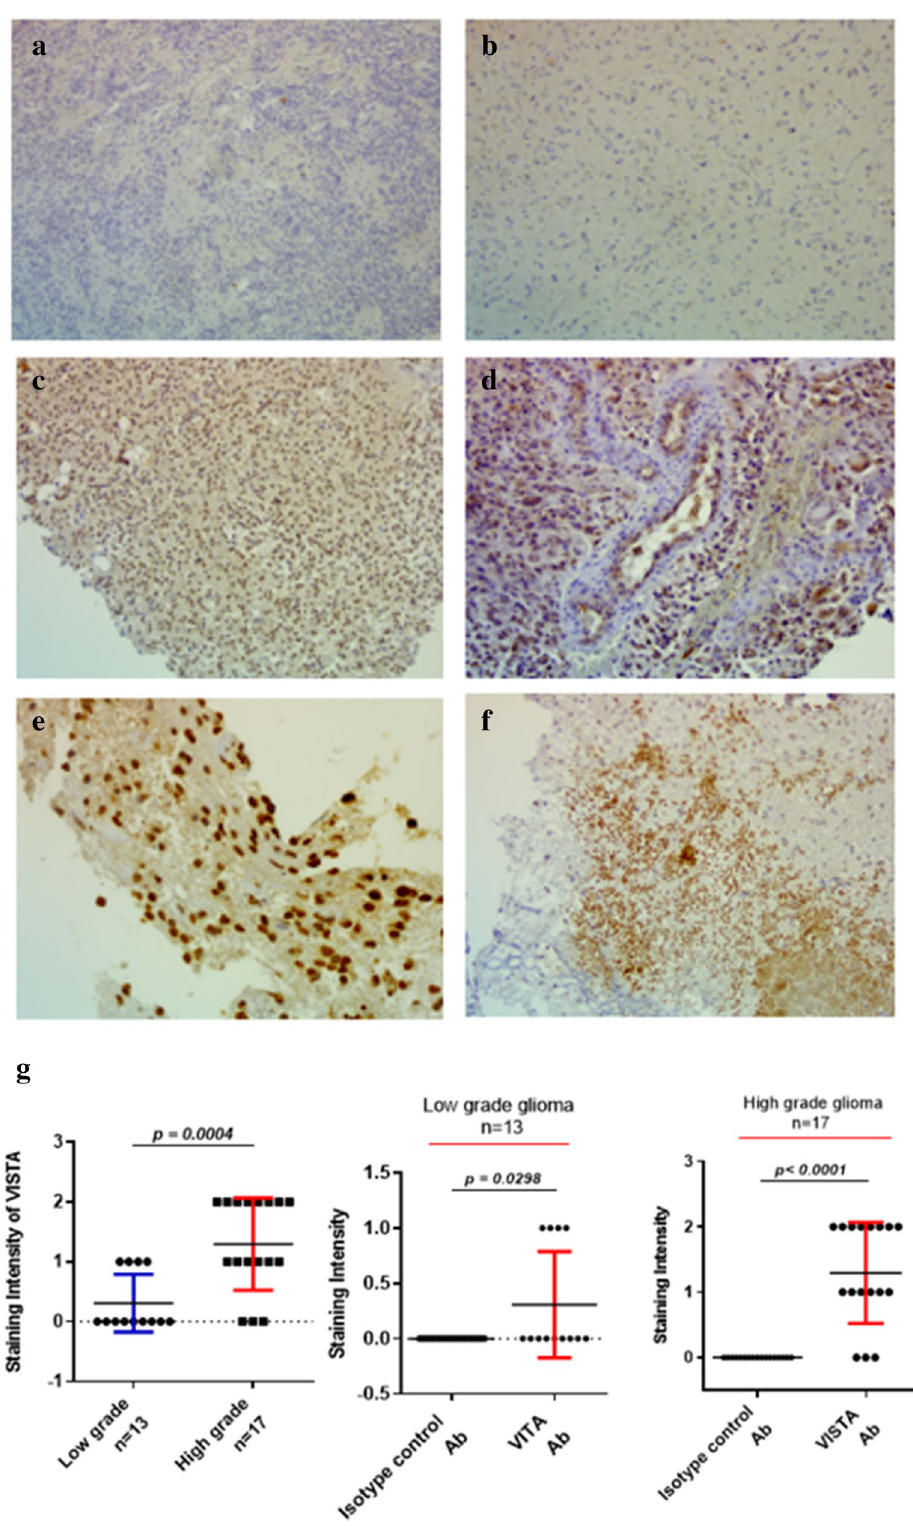
Figure 2. Immunohistochemical staining of VISTA revealed elevated expression levels in high grade gliomas. Representative staining intensity of VISTA protein was detected in human glioma tissues (Moroccan cohort) using immunohistochemistry assay. ( a ) Negative control staining in glioma case with Rabbit IgG Isotype Control (magnification × 20). ( b ) Negative staining of VISTA in low grade glioma (grade I). ( c ) Positive staining of VISTA in high grade glioma (Glioblastoma IV) (magnification × 20). ( d ) Positive staining of VISTA on endothelial cells (magnification × 20). ( e ) Positive staining of VISTA on glioma cells (magnification × 40). ( f ) Positive staining of VISTA on immune cells in a glioblastoma case (magnification × 20). ( g ) Expression of VISTA according to glioma grades. Statistical analysis was performed by using a t-test to compare the expression of VISTA between different grades of glioma patients. p value less than 0.05 was considered as statistically significant for all statistical